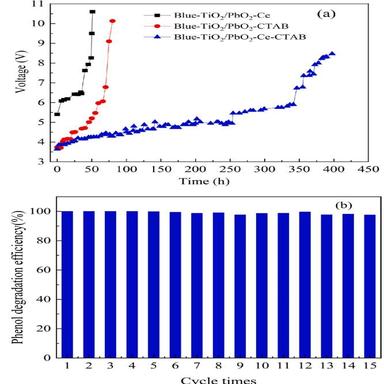
Stability test of different electrodes: (a) Accelerated life curve of different electrodes ( = 0.5 M, current density = 100 mA cm− 2 ); (b) Number of times of repeated use of Blue-TiO2/PbO2-Ce-CTAB electrode ( = 100 mg/L, = 0.15 M, current density = 25 mA cm− 2 ). (For interpretation of the references to color in this figure legend, the reader is referred to the web version of this article.)